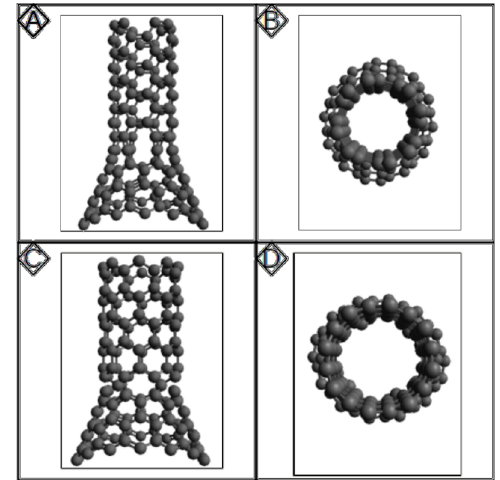
Figure 8. ( A ) Sideview of a carbon nanotube (4,4) of input length 1 nm with a carbon nanocone of disclination level 4 and base radius of 10 Å. ( B ) Top view of a carbon nanotube (4,4) of input length 1 nm with a carbon nanocone of disclination level 4 and base radius of 10 Å. ( C ) Sideview of a carbon nanotube (8,0) of input length 1 nm with a carbon nanocone of disclination level 4 and base radius of 10 Å. ( D ) Top view of a carbon nanotube (8,0) of input length 1 nm with a carbon nanocone of disclination level 4 and base radius of 10 Å.